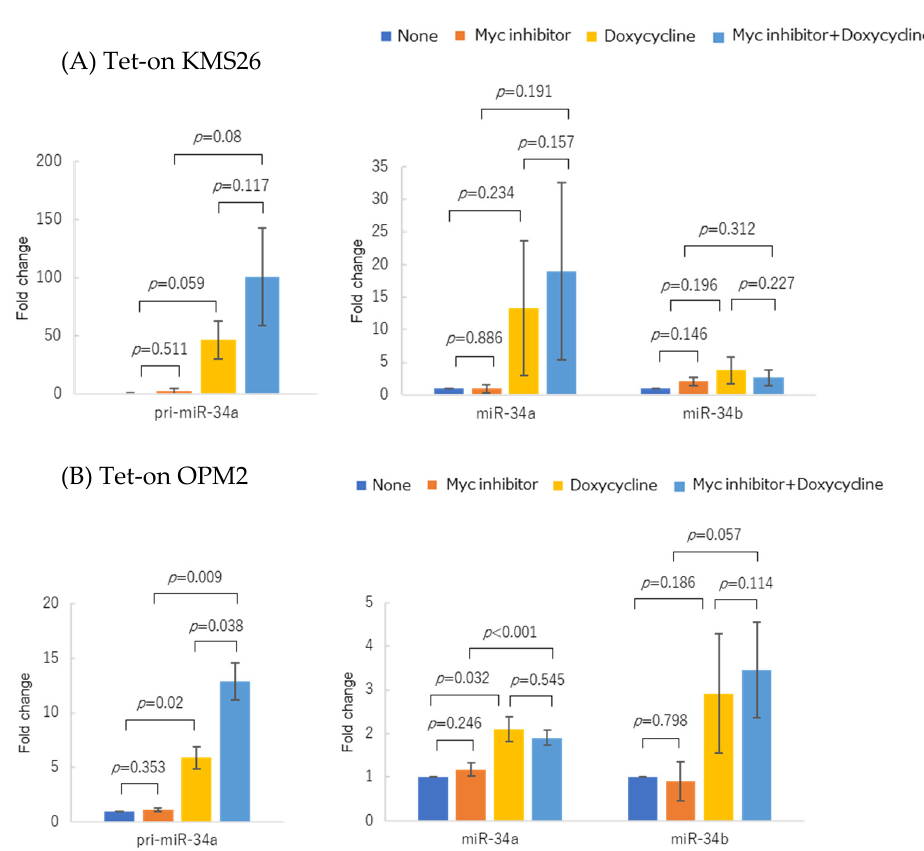
Figure 7. Changes in pri-miR-34a and mature miR-34a/b expressions in two Tet-on p53 myeloma cell lines after treatment with Myc inhibitor 10058-F4 and doxycycline. ( A ) KMS26 and ( B ) OPM2 were treated for 72 h with 20 µM Myc inhibitor and/or 1 µg/mL doxycycline. Experiments were per-formed in triplicate. Error bars show the standard deviation (SD) within triplicated experiments. Blue, no treatment; orange, with 20 µM Myc inhibitor; yellow, with 1 µg/mL doxycycline; light blue, with co-treatment of Myc inhibitor and doxycycline. Blue and yellow bars show the same data as Figure 3.